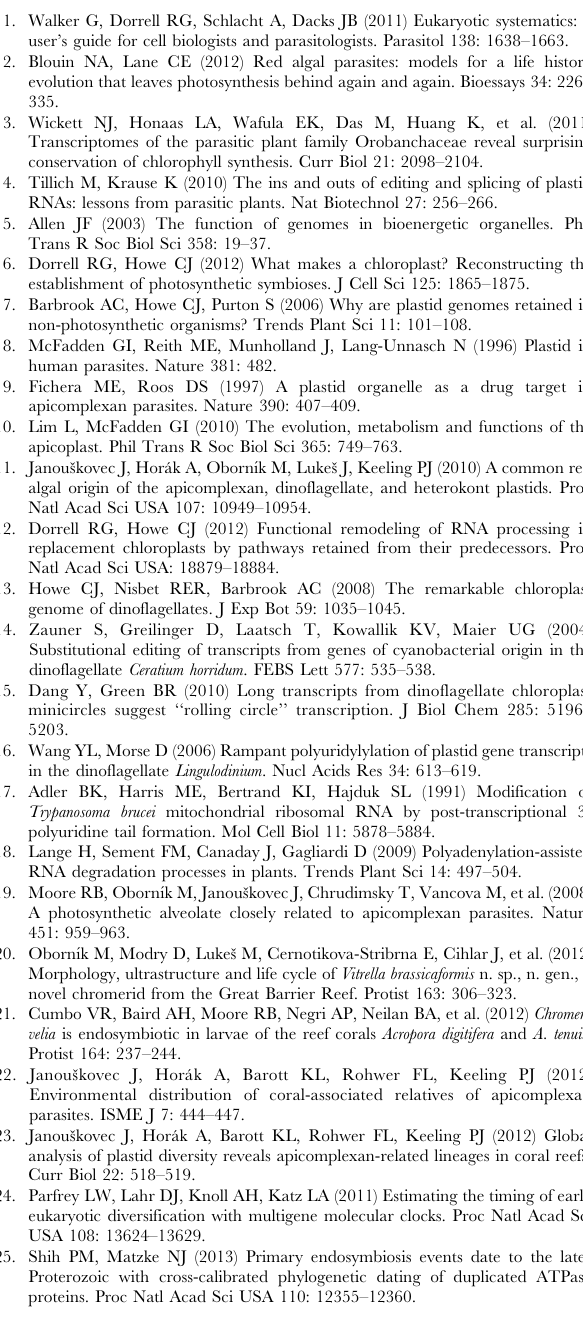
detected in the corresponding northern blots (figs. 5, 6) are highlighted in bold. Table S6 Tabulated probes used for northern blots of Chromera velia chloroplast transcripts. For each probe, both the sequence itself, including the T7 arm of the pGEM-tEasy vector, and the positions on the C. velia chloroplast genome from which the probe was generated are